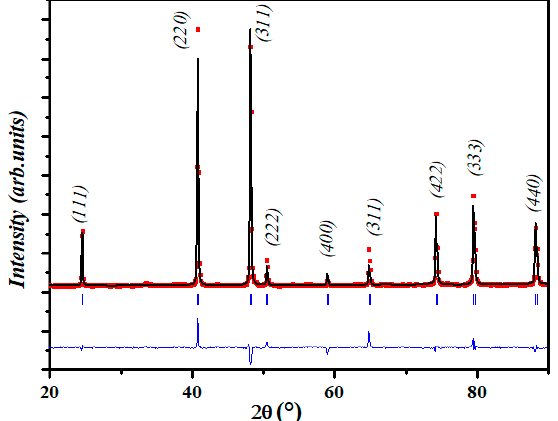
Figure 2. Observed (red) and calculated (black) XRD patterns of Er(Fe 0.8 Mn 0.2 Co 0.1 ) 2 . The difference pattern is plotted at the bottom. Bragg reflections are indicated by ticks.